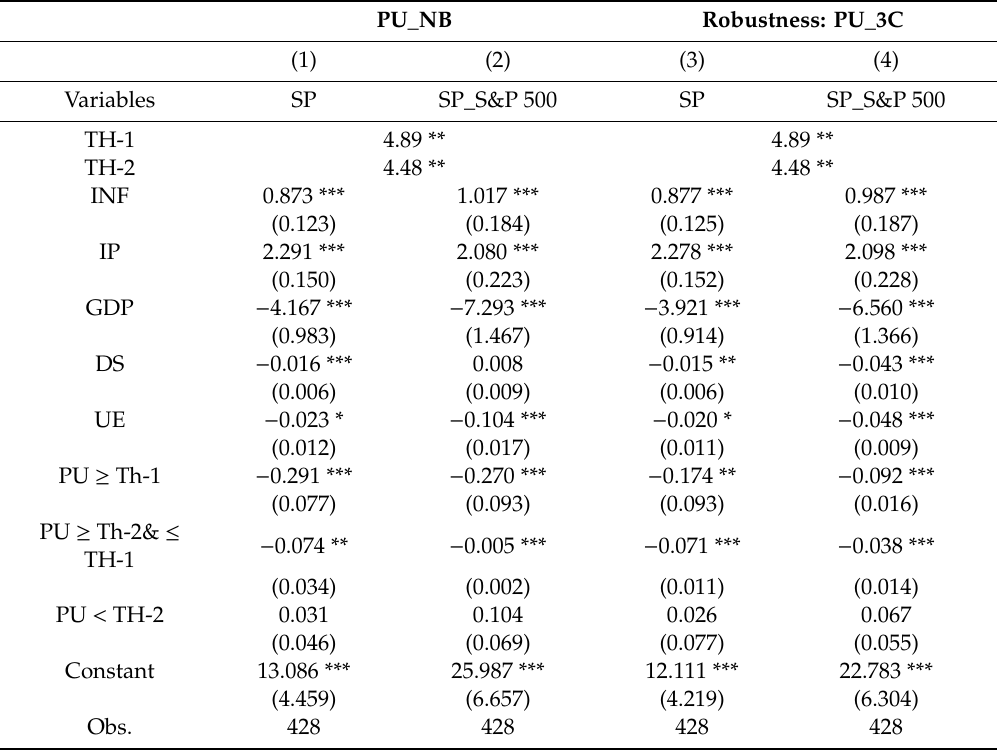
Table 5. Threshold regression results.